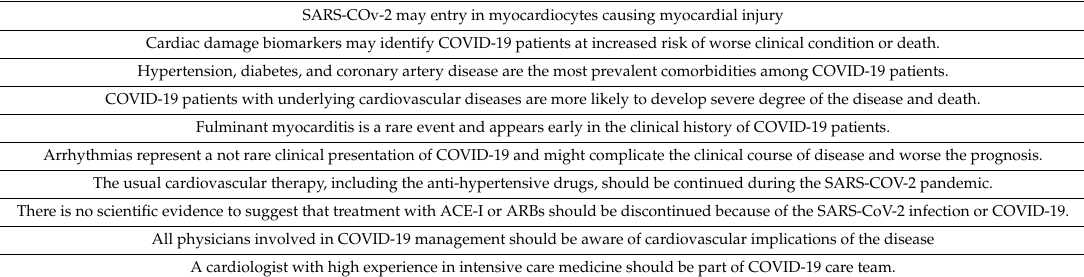
Table 4. COVID-19 and HEART: HIGHLIGHTS